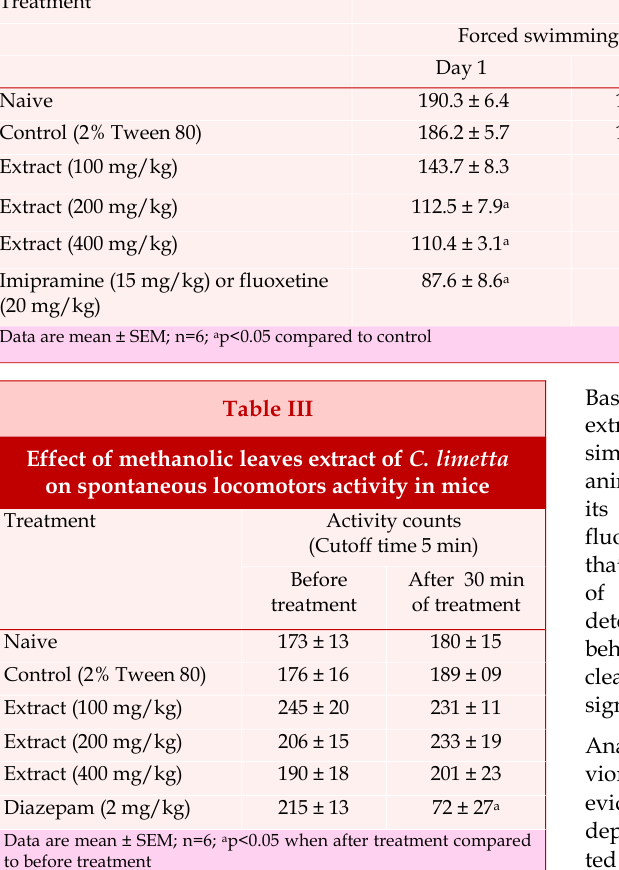
Effect of methanolic extract of C. limetta on immobility time in mice